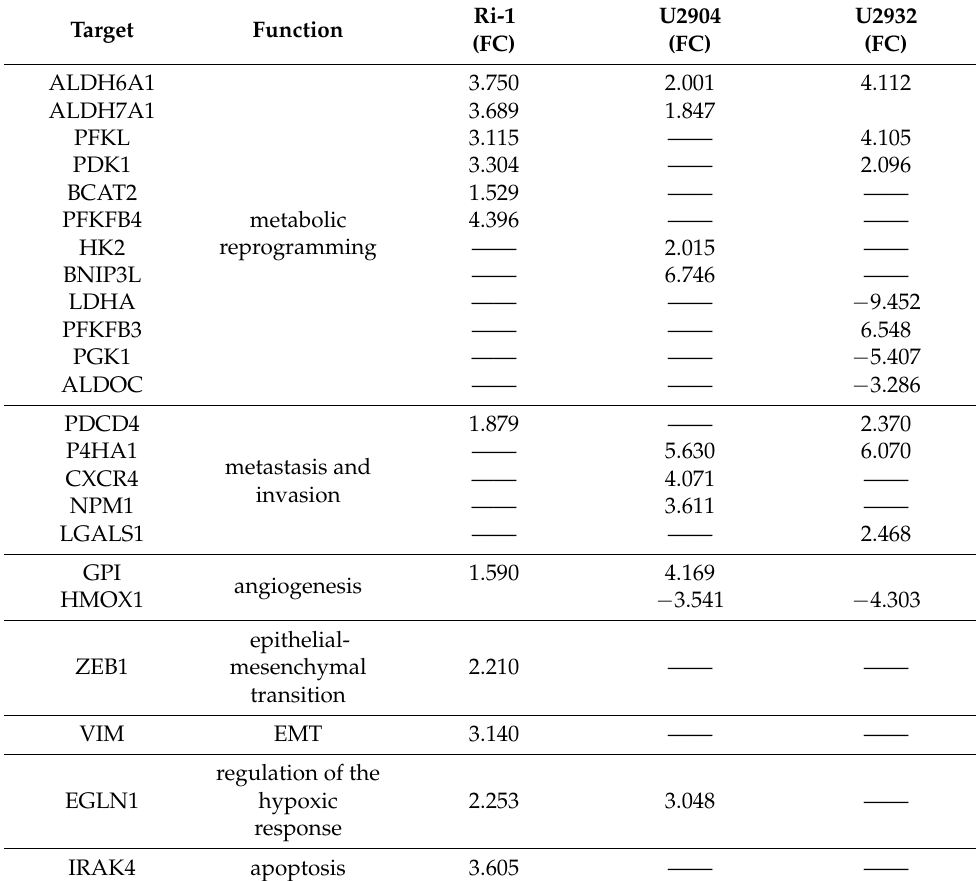
Table 2. The list of HIF-1 α targets being differentially expressed in Ri-1, U2904, and U2932 cell lines under hypoxia. FC- fold